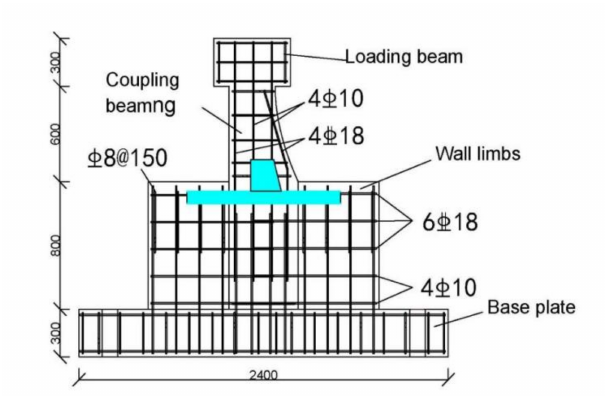
Figure 6. Schematic of the specimen reinforcement layout